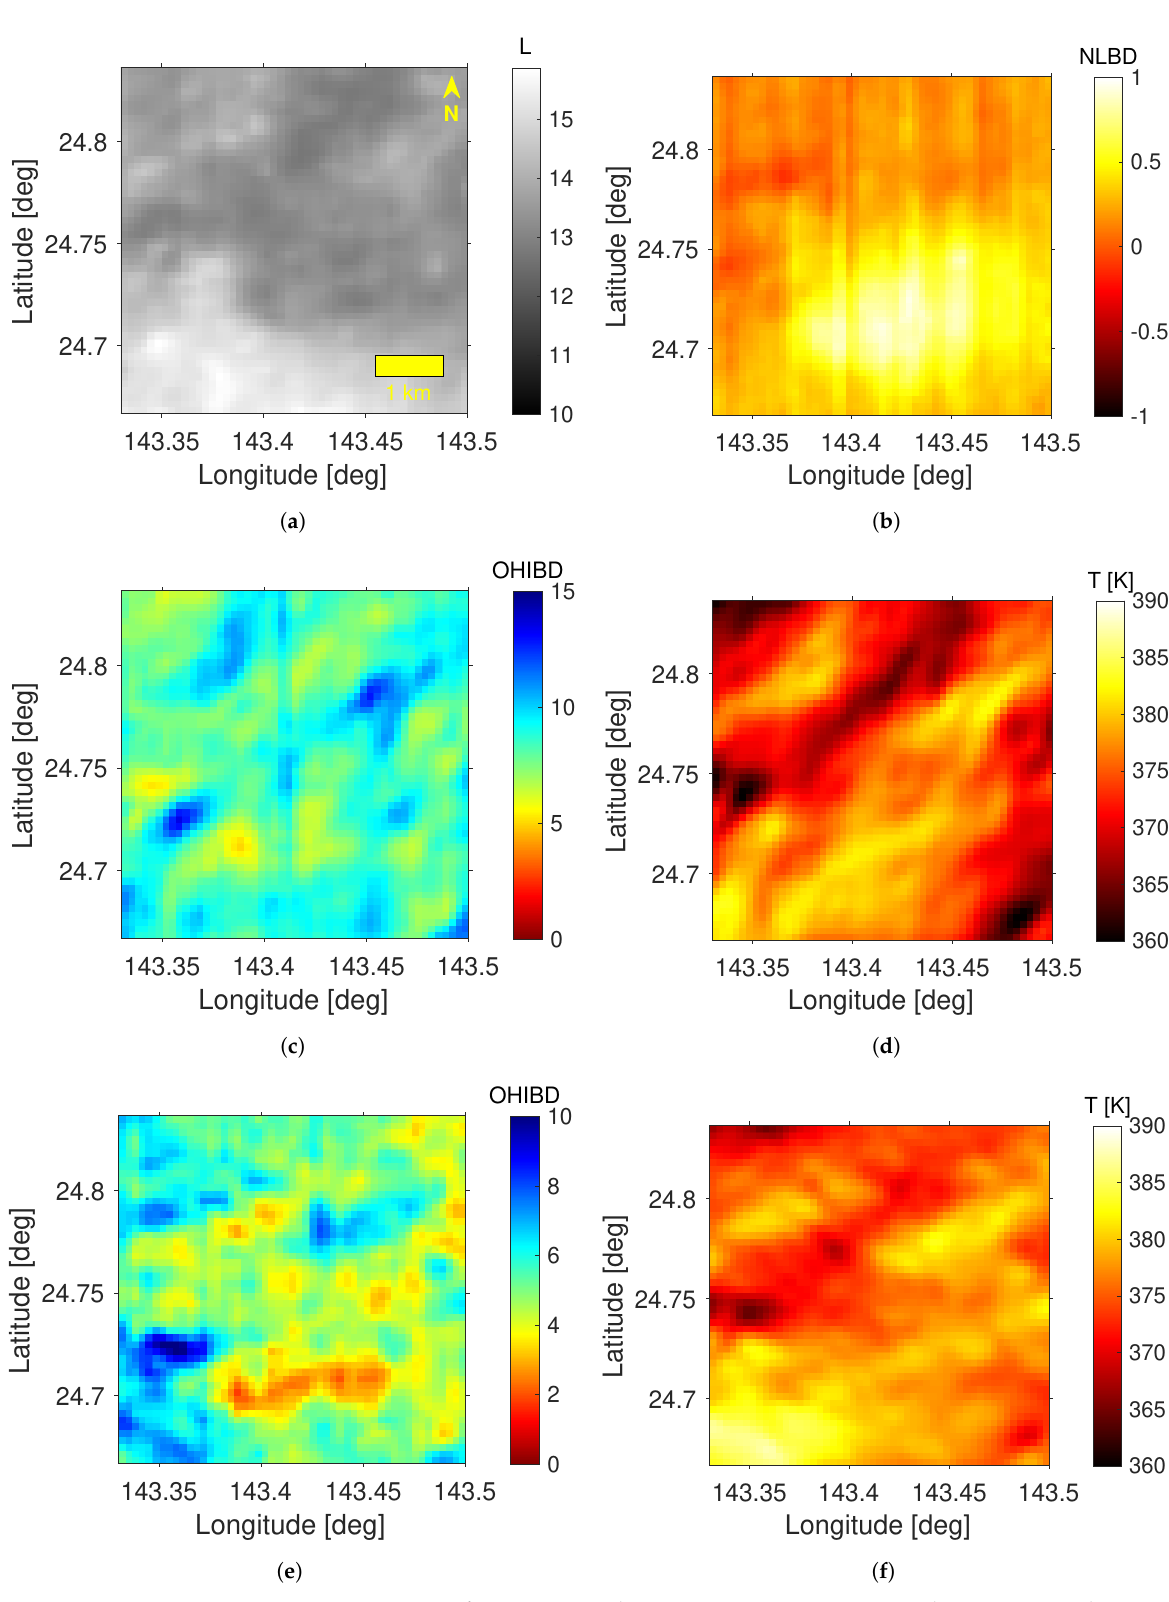
Figure 15. Region of interest near the western Mare Moscoviense basin ring. High NLBD values coincide with low OHIBD values at lunar midday, but at lunar morning, the high-NLBD areas blend into the surrounding areas. ( a ) Radiance image, ( b ) NLBD parameter map, ( c ) OHIBD at 09:20 (percent), ( d ) Temperature at 09:20 (K), ( e ) OHIBD at 11:15 (percent), ( f ) Temperature at 11:15